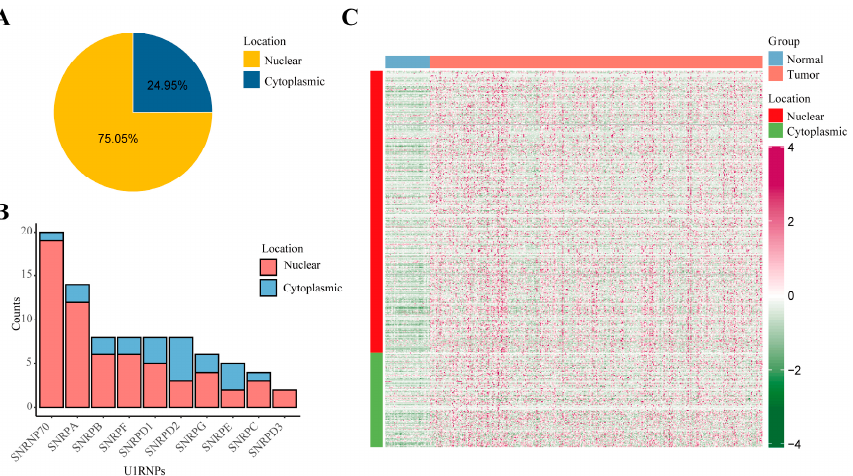
Figure 2. Distribution and expression of U1-lncRNAs in HCC. ( A ) Pie plot showing location of tu- specific lncRNAs with U1-binding motif in LncAtlas database. ( B ) Bar plot showing the overall their expression level. The criteria for significant correlation were: p < 0.05; |R| > 0.5. ( C ) Heatmap showing the expression and location of tumor specific lncRNAs within tumor and normal